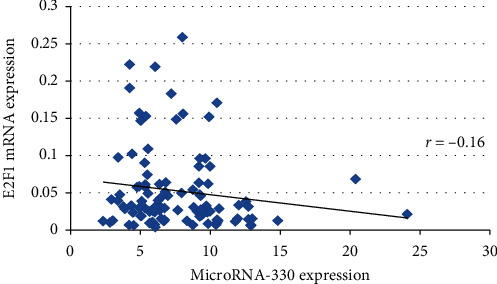
Correlation of microRNA-330 and E2F1 mRNA expression among T2DM cases.